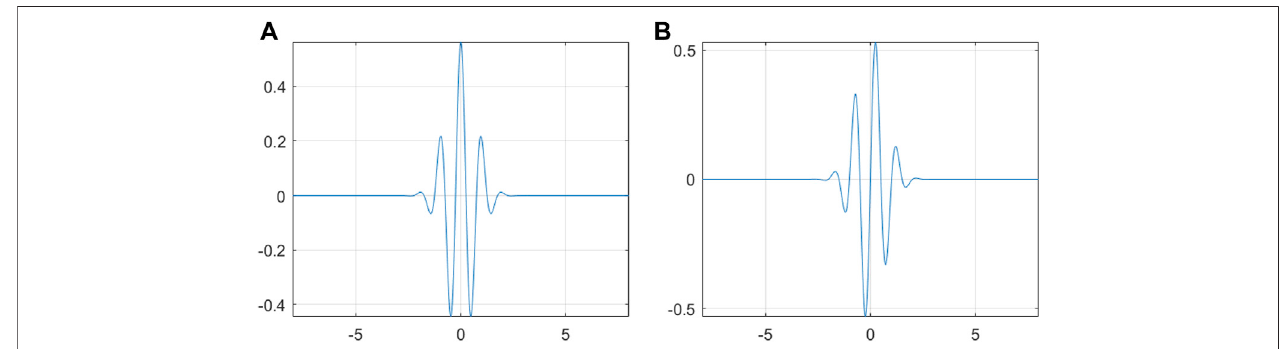
FIGURE 4 | (A) Real part of the complex Morlet wavelet and (B) Imaginary part of the complex Morlet wavelet.